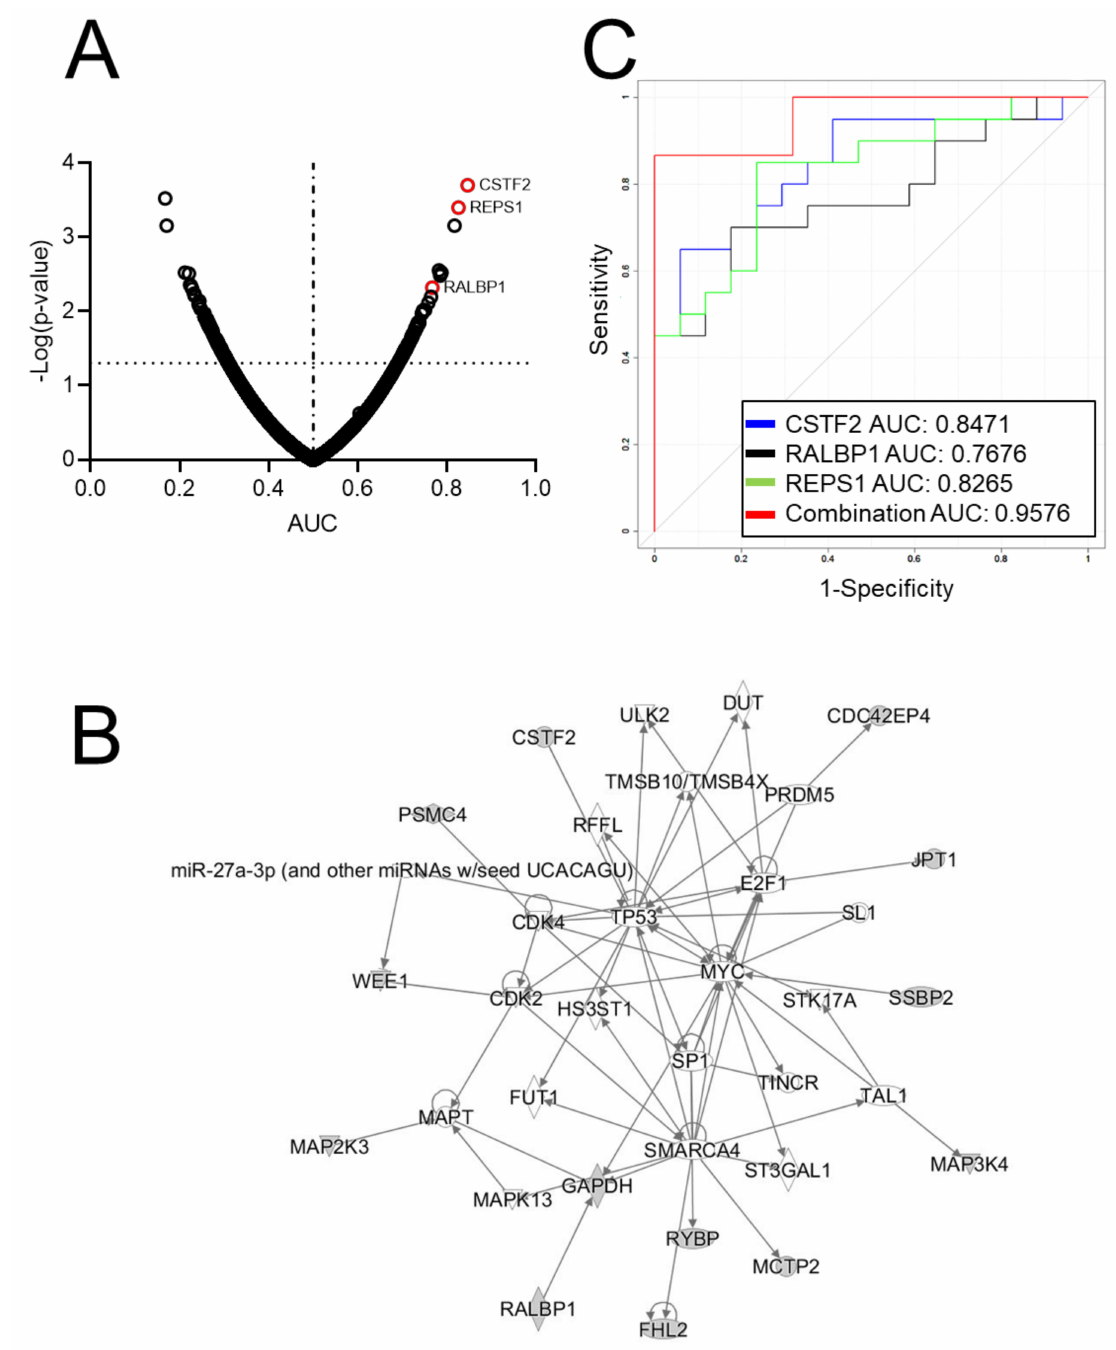
Figure 1. Ovarian cancer autoantibody signature based on recombinant protein array analysis. ( A ) Volcano plot illustrating the AUC ( x -axis) and –log10 ( p -value) ( y -axis) distribution of autoantibodies against 5005 recombinant proteins. Dashed line indicates border line of significance (Y = 1.3) and solid line indicates AUC = 0.5. ( B ) Ingenuity Pathway Analysis (IPA) network based on the top 25 performing autoantibodies based on AUC point estimates. ( C ) Classification performance of autoantibodies against CSTF2, RALBP1, REPS1 and the combination of the three markers in distinguishing ovarian cases from